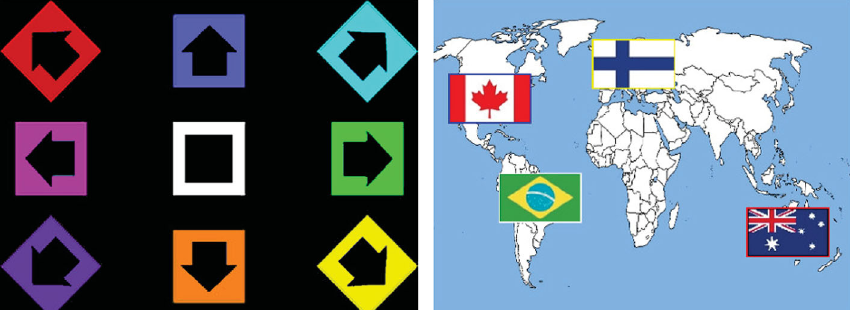
Fig. 6 Applications chosen for observation, from left to right: Grid and Simple Map